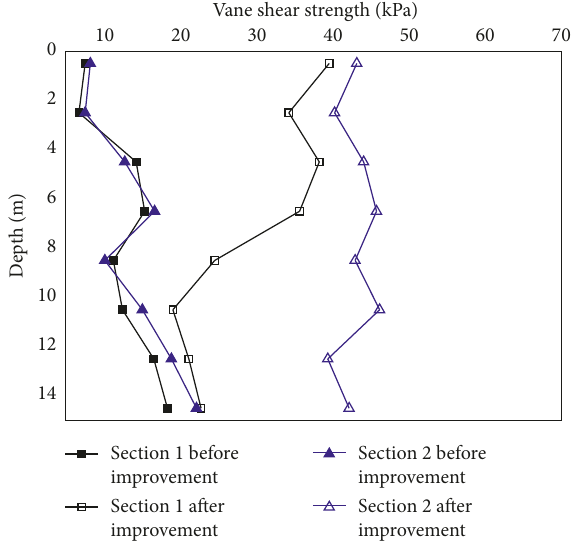
Figure 15: Water contents plotted as functions of depth for sec- tions 1 and 2.